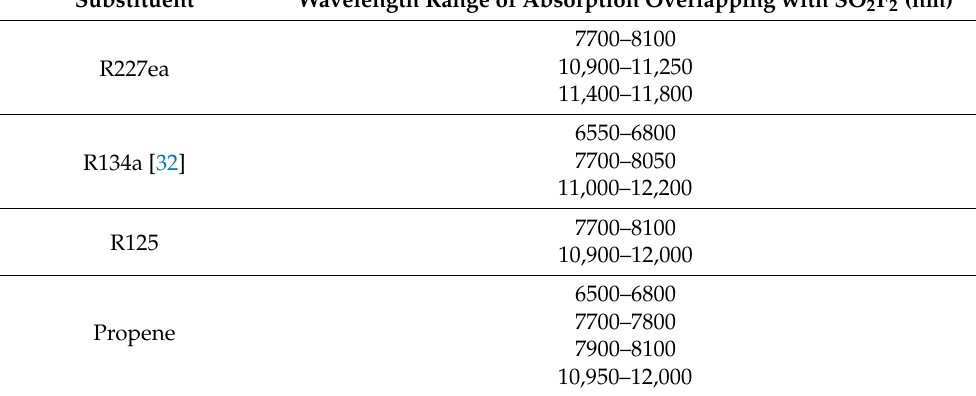
Table 2. List of the substituent gases with the wavelength ranges of absorption that overlapped with SO 2 F 2